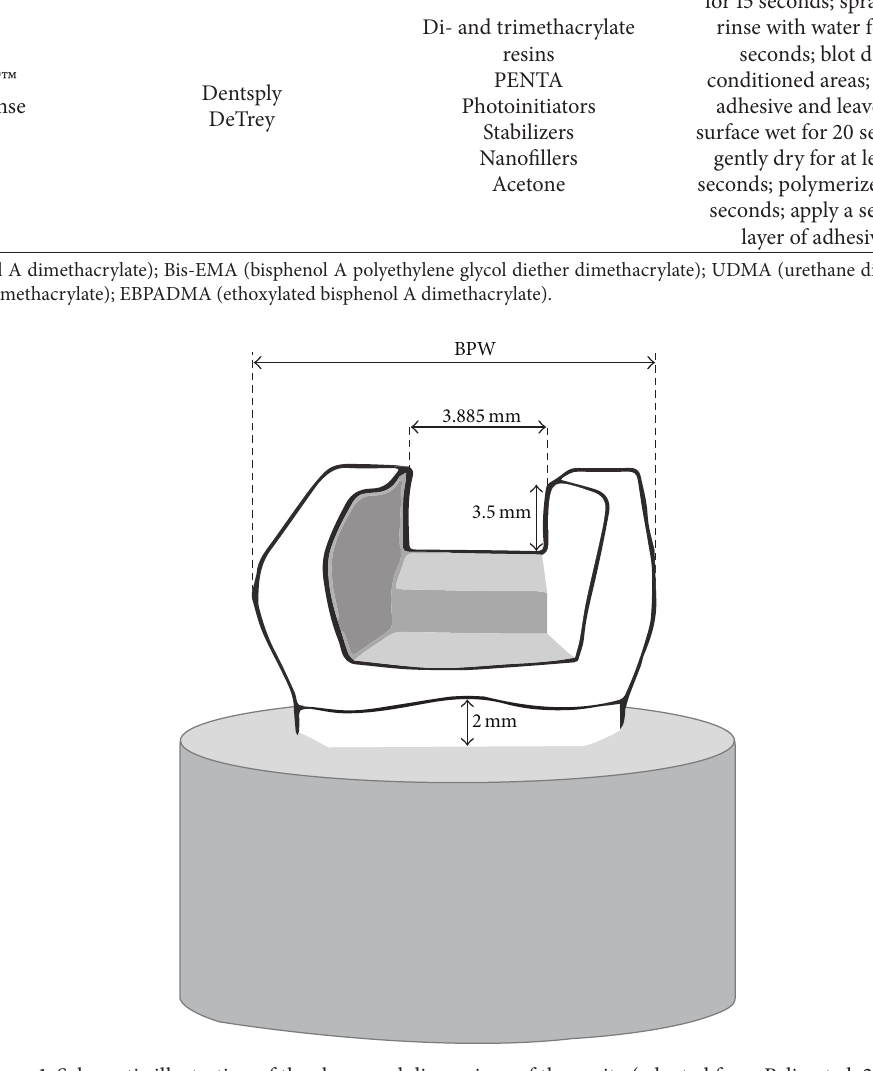
Figure 1: Schematic illustration of the shape and dimensions of the cavity (adapted from Palin et al. 2005